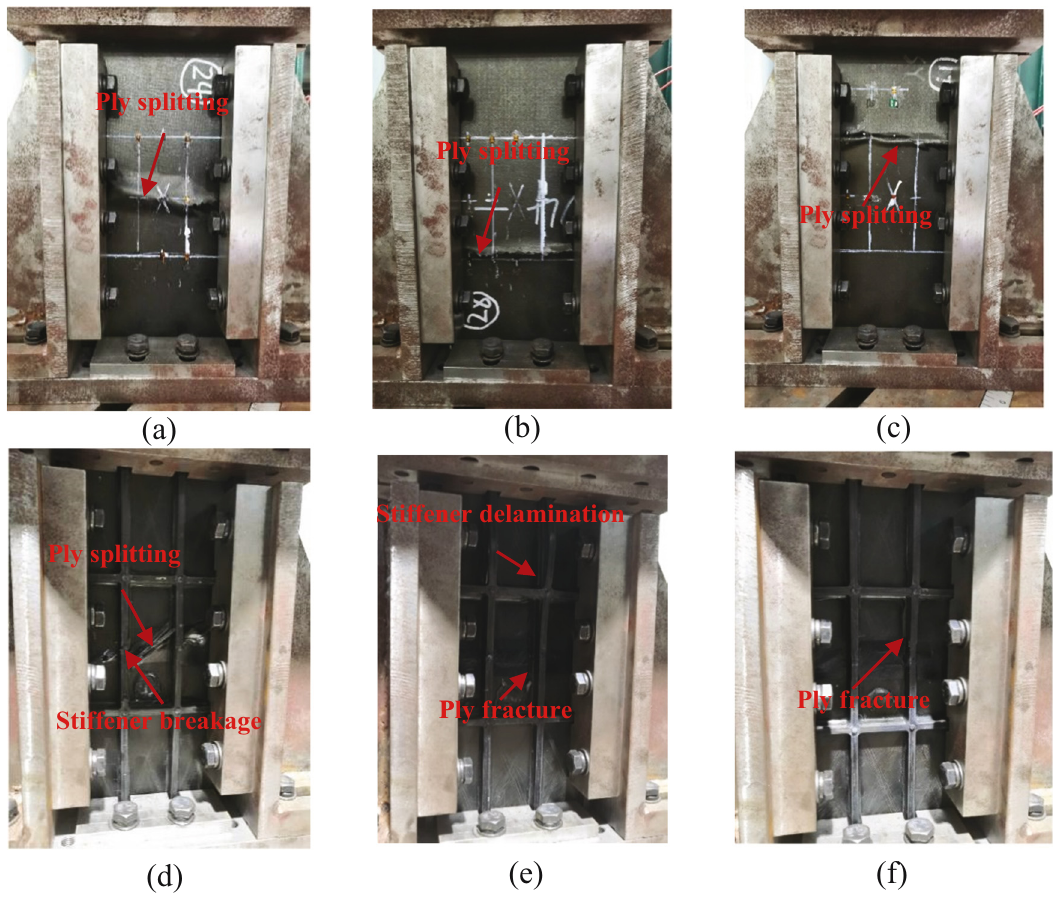
Figure 12: Compression damage of the specimen after aging for 90 days: ( a and d ) #10; ( b and e ) #11; and ( c and f ) #12.